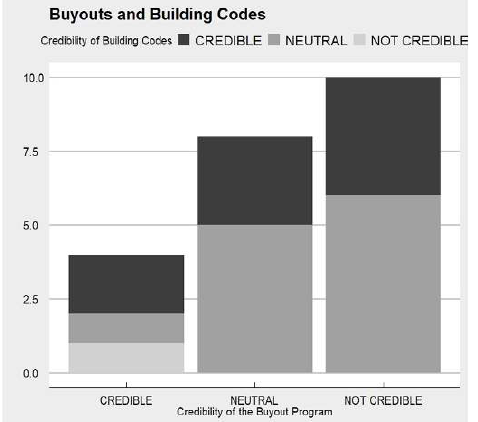
Figure 3: Perceived credibly of the Post Disaster Buyout Program and perceived credibility of restrictive building codes/enforcement of base flood elevation/freeboard requirements